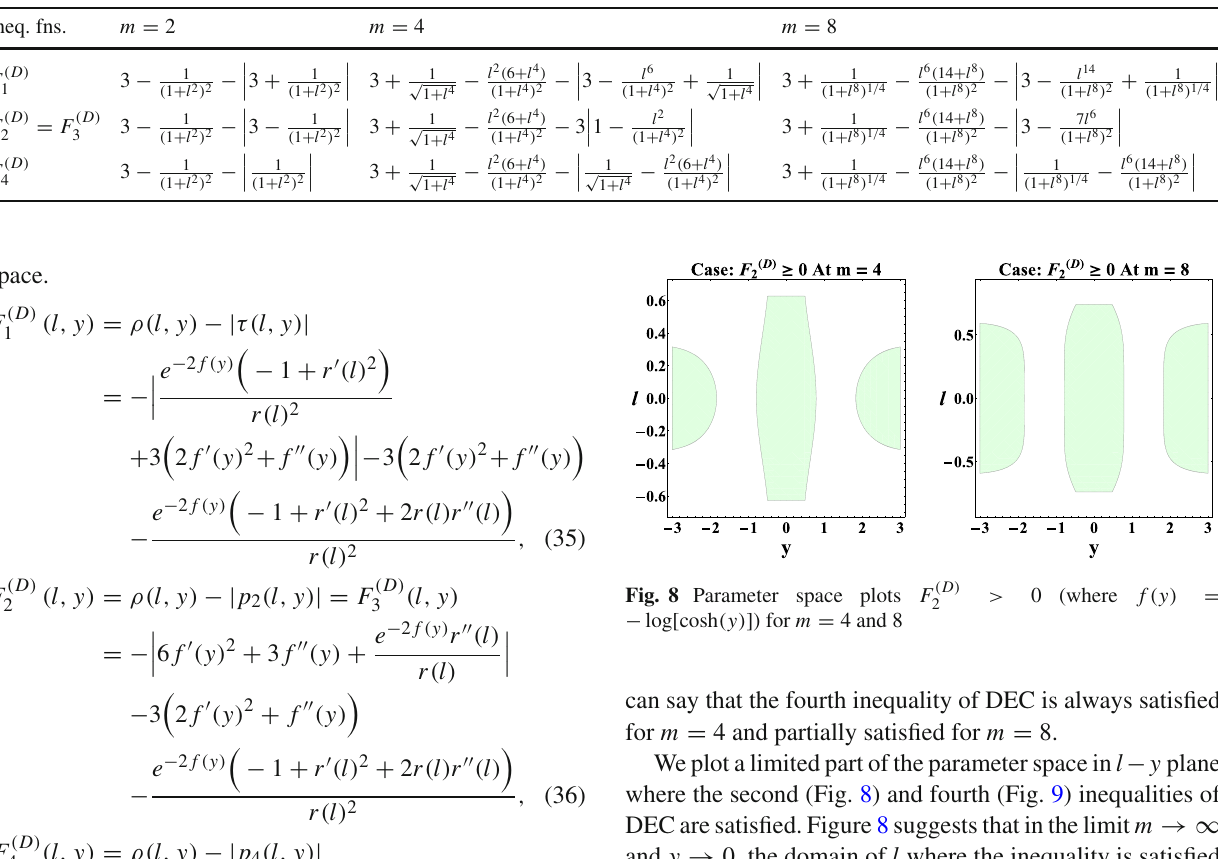
i.e. on the brane and near the